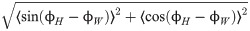
Summary of findings on the θ-rhythm in a rat during a texture discrimination task, derived from reference [32].
(A) Spectrogram showing the change in spectral power of the local field potential in the hippocampal area CA1 before, during, and after a whisking-based discrimination task. (B) Summary index of the increase in coherence between the band-limited hippocampal θ-rhythm and whisking signals during approach of the rat to the stimulus and subsequent touch. The index reports 〈sin(ϕH−ϕW)〉2+〈cos(ϕH−ϕW)〉2, where ɸH and ɸW are the instantaneous phase of the hippocampal and whisking signals, respectively, and averaging is over all trials and animals. (C) Summary indices of the increase in coherence between the band-limited hippocampal θ-rhythm and the spiking signal in the vibrissa primary sensory cortex (“barrel cortex”). The magnitude of the index for each neuron is plotted versus phase in the θ-rhythm. The arrows show the concentration of units around the mean phase—black arrows for the vector average across only neurons with significant phase locking (solid circles) and gray arrows for the vector average across all neurons (open and closed circles). The concurrent positions of the vibrissae are indicated. The vector average is statistically significant only for the approach (p < 0.0001) and touch (p = 0.04) epochs.